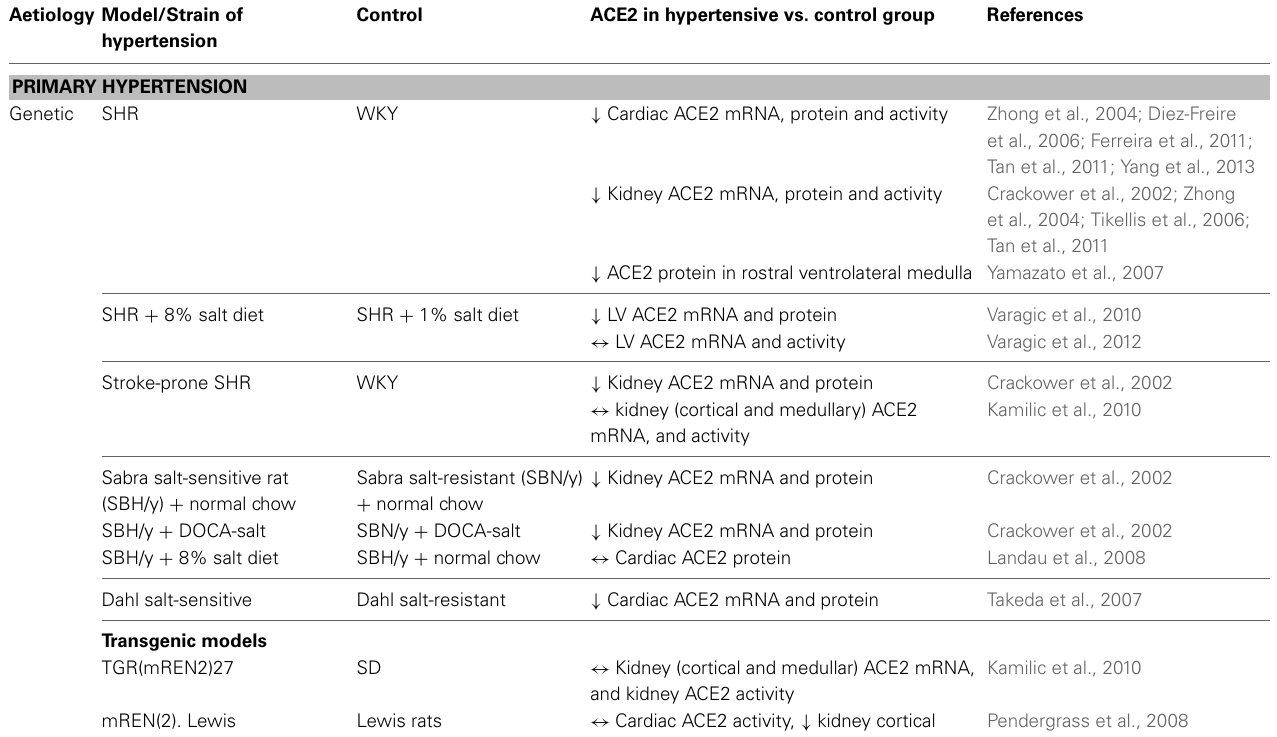
Table 1 | ACE2 and experimental